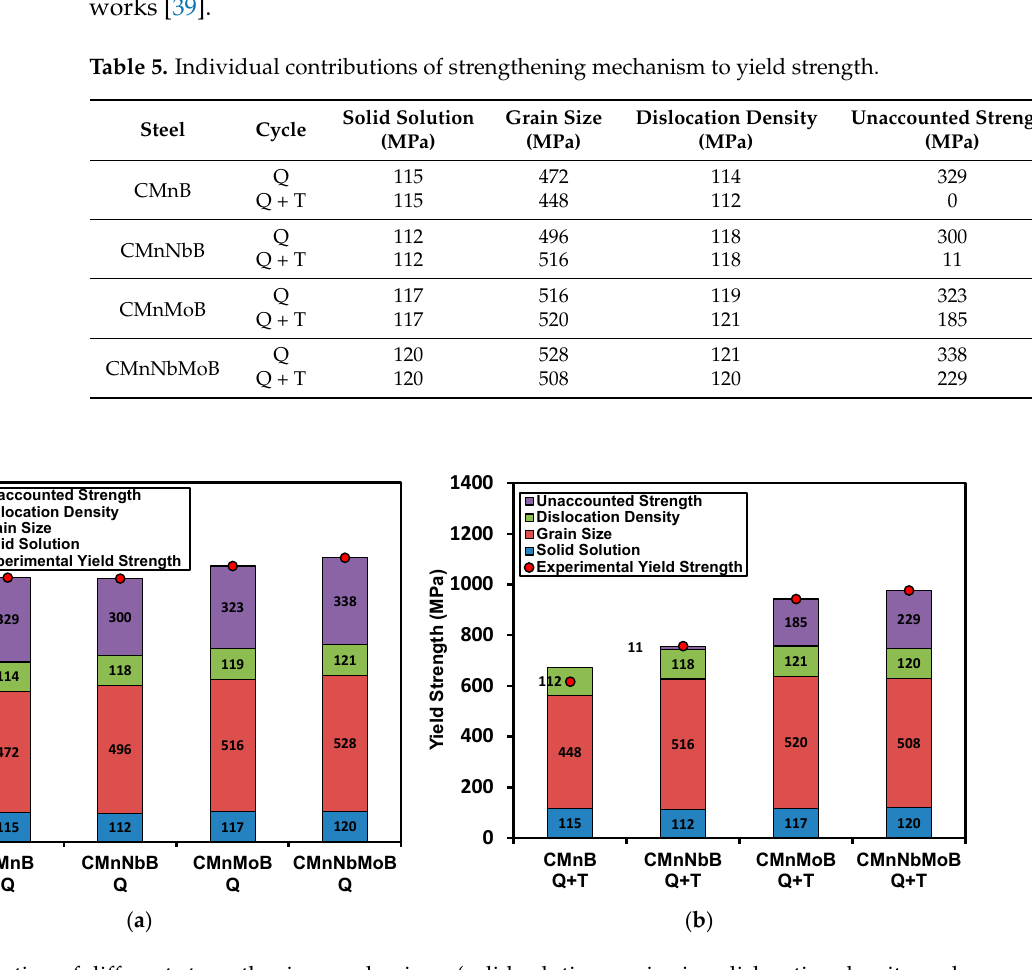
Figure 12. Contribution of different strengthening mechanisms (solid solution, grain size, dislocation density and unac- counted strength) to the yield strength: ( a ) Q and ( b ) Q + T states. Table 5. Individual contributions of strengthening mechanism to yield strength.